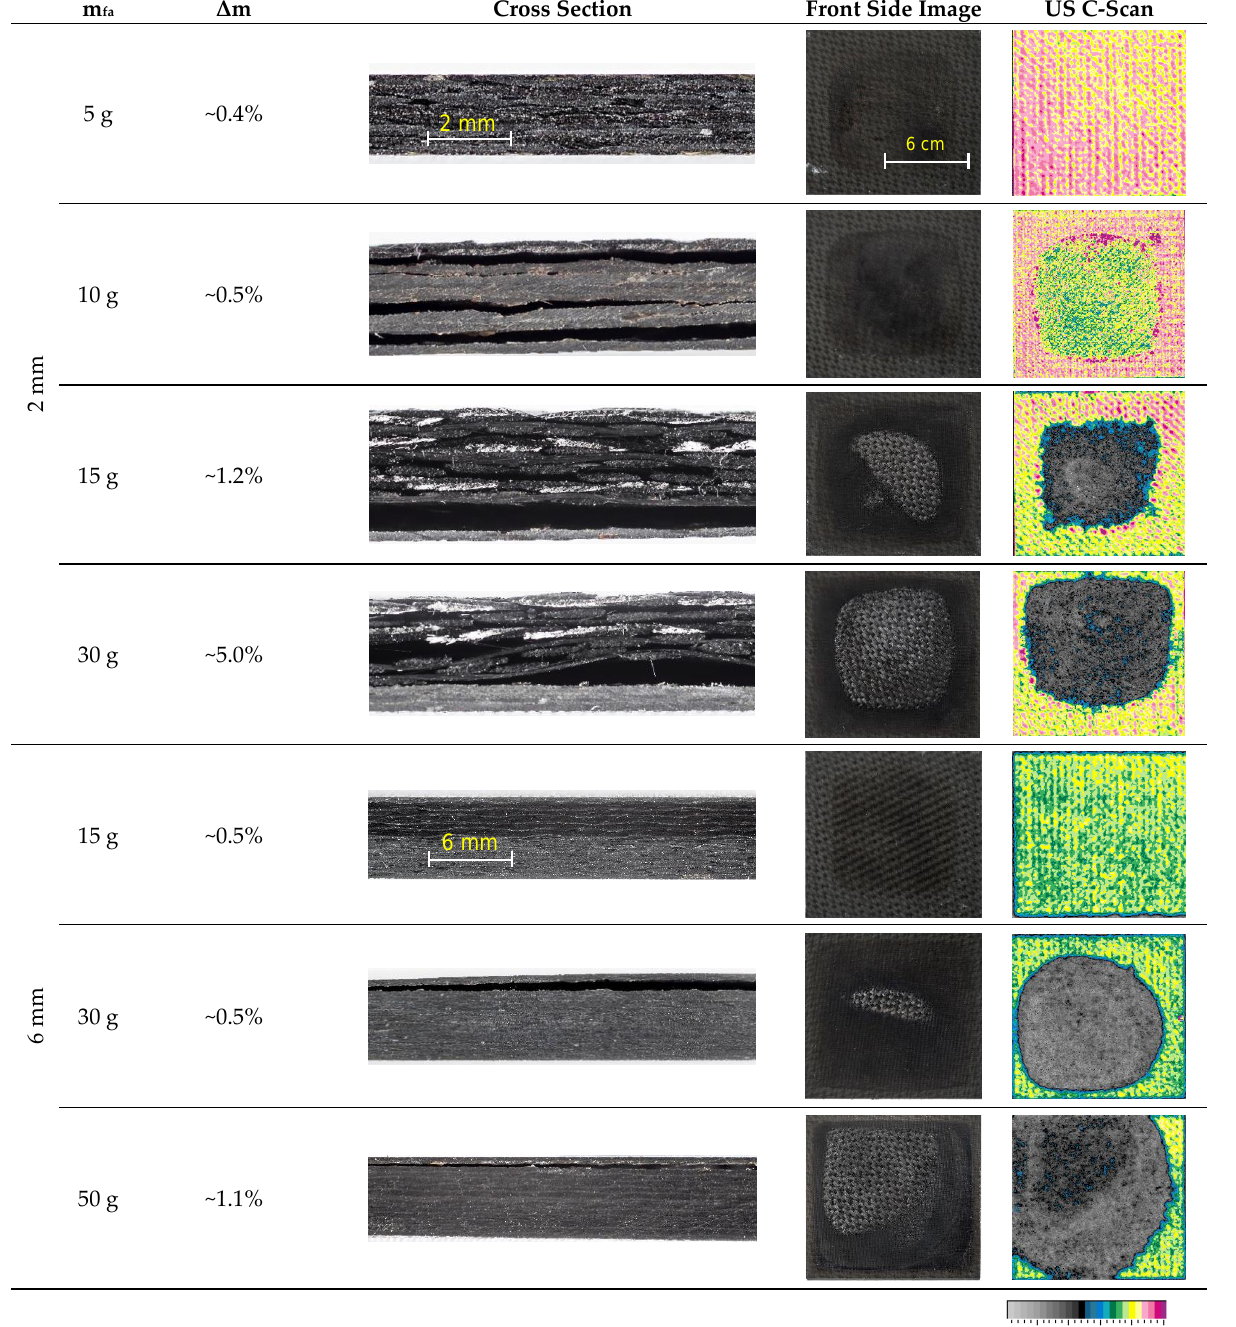
Figure 9. Cross sections (hot side on top), photographs and ultrasonic C-scans of 2 and 6 mm thick M18-1/G939 panels after impact of various amounts of fire accelerant. Mass loss (Δm) is additionally given.